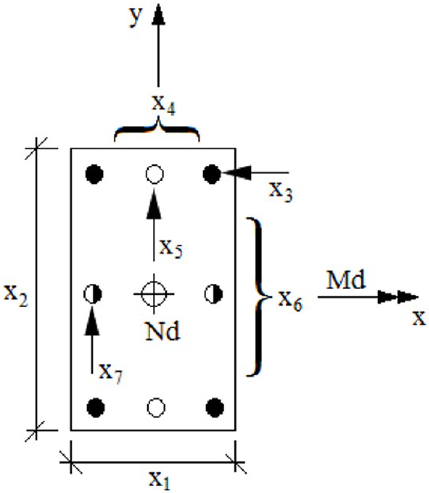
Figure 5. Column optimization design variables Source: Bordignon and Kripka [33]